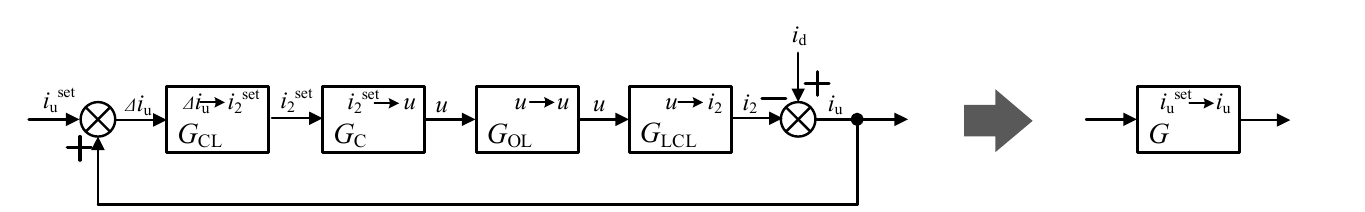
Figure 8. Z -domain equivalent control block diagrams.